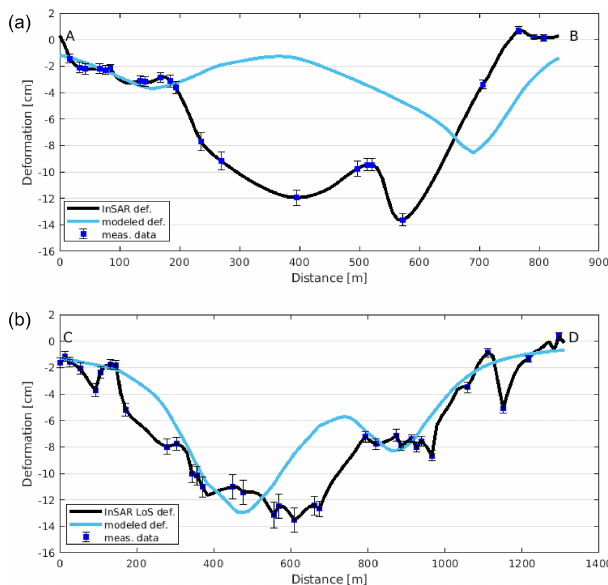
Figure 15. Observed cumulative LOS and best-fitting model LOS deformations along selected profiles (given in Figs. 9 and 10) for the ascending (a) and descending (b)